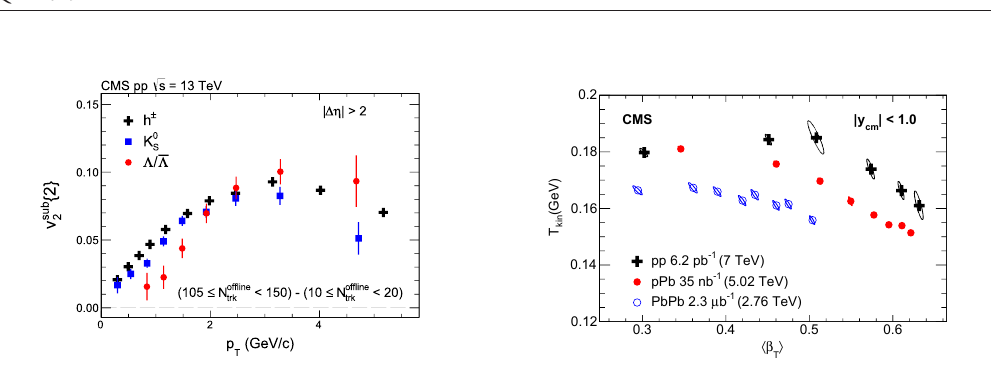
and Λ / ¯ Λ particles as a function of p T for high S and Λ particles p T spectra for di ff erent multiplicity intervals in pp , S